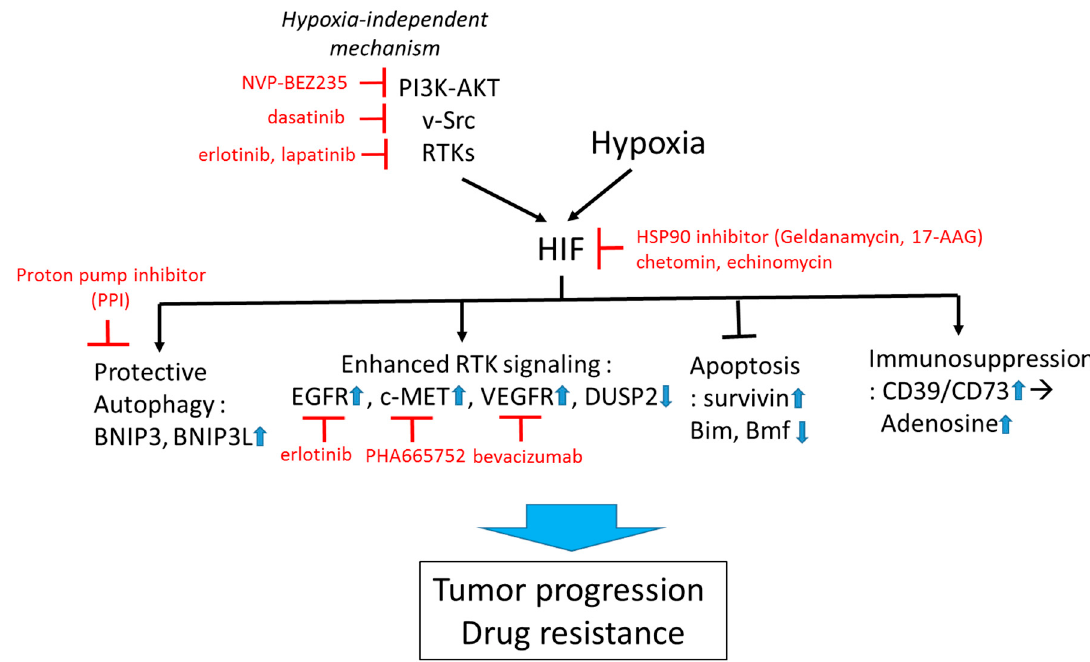
Figure 2. Targeting HIF to overcome hypoxia-associated drug resistance. HIF can be induced by both hypoxia-dependent and -independent mechanisms. Active HIF in tumor cells promotes drug resistance via upregulation of cytoprotective autophagy, receptor tyrosine kinase (RTK) signaling, suppression of apoptosis, and promotion of immunosuppressive tumor microenvironment. Examples of pharmacological approaches targeting HIF-regulating and -regulated mechanisms are shown in red. Small blue arrows indicate the direction of changes of protein abundance or activity after HIF activation.